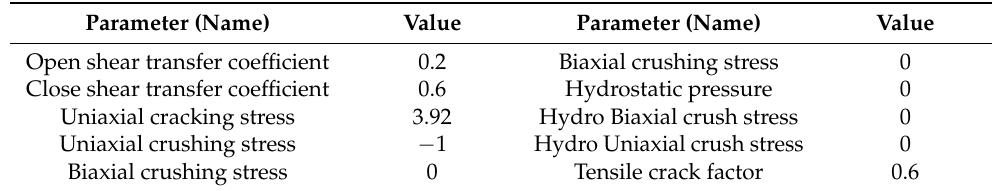
Figure 7. Typical stress–strain curve used for ( a ) concrete and ( b ) steel. Table 8. Coefficients used for concrete.